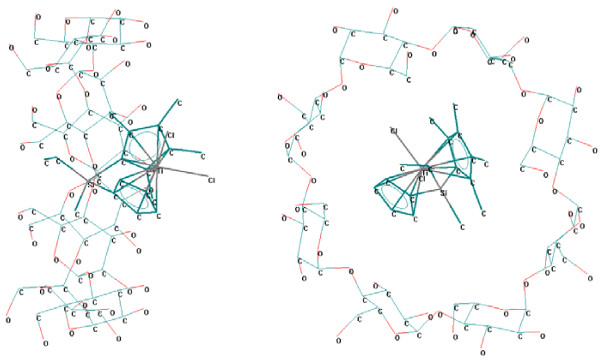
Titanocene (code 01TC) / γ-cyclodextrin supramolecular system (theoretically modeled by MM+).